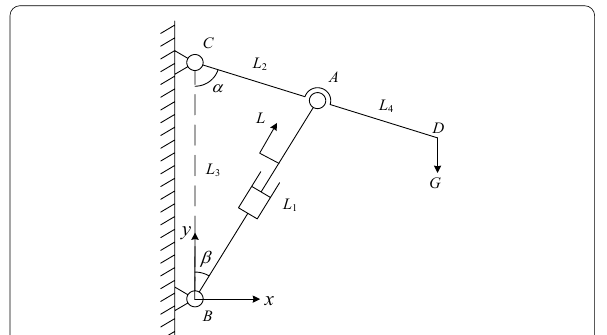
Figure 2 Schematic diagram of the lifting mechanism